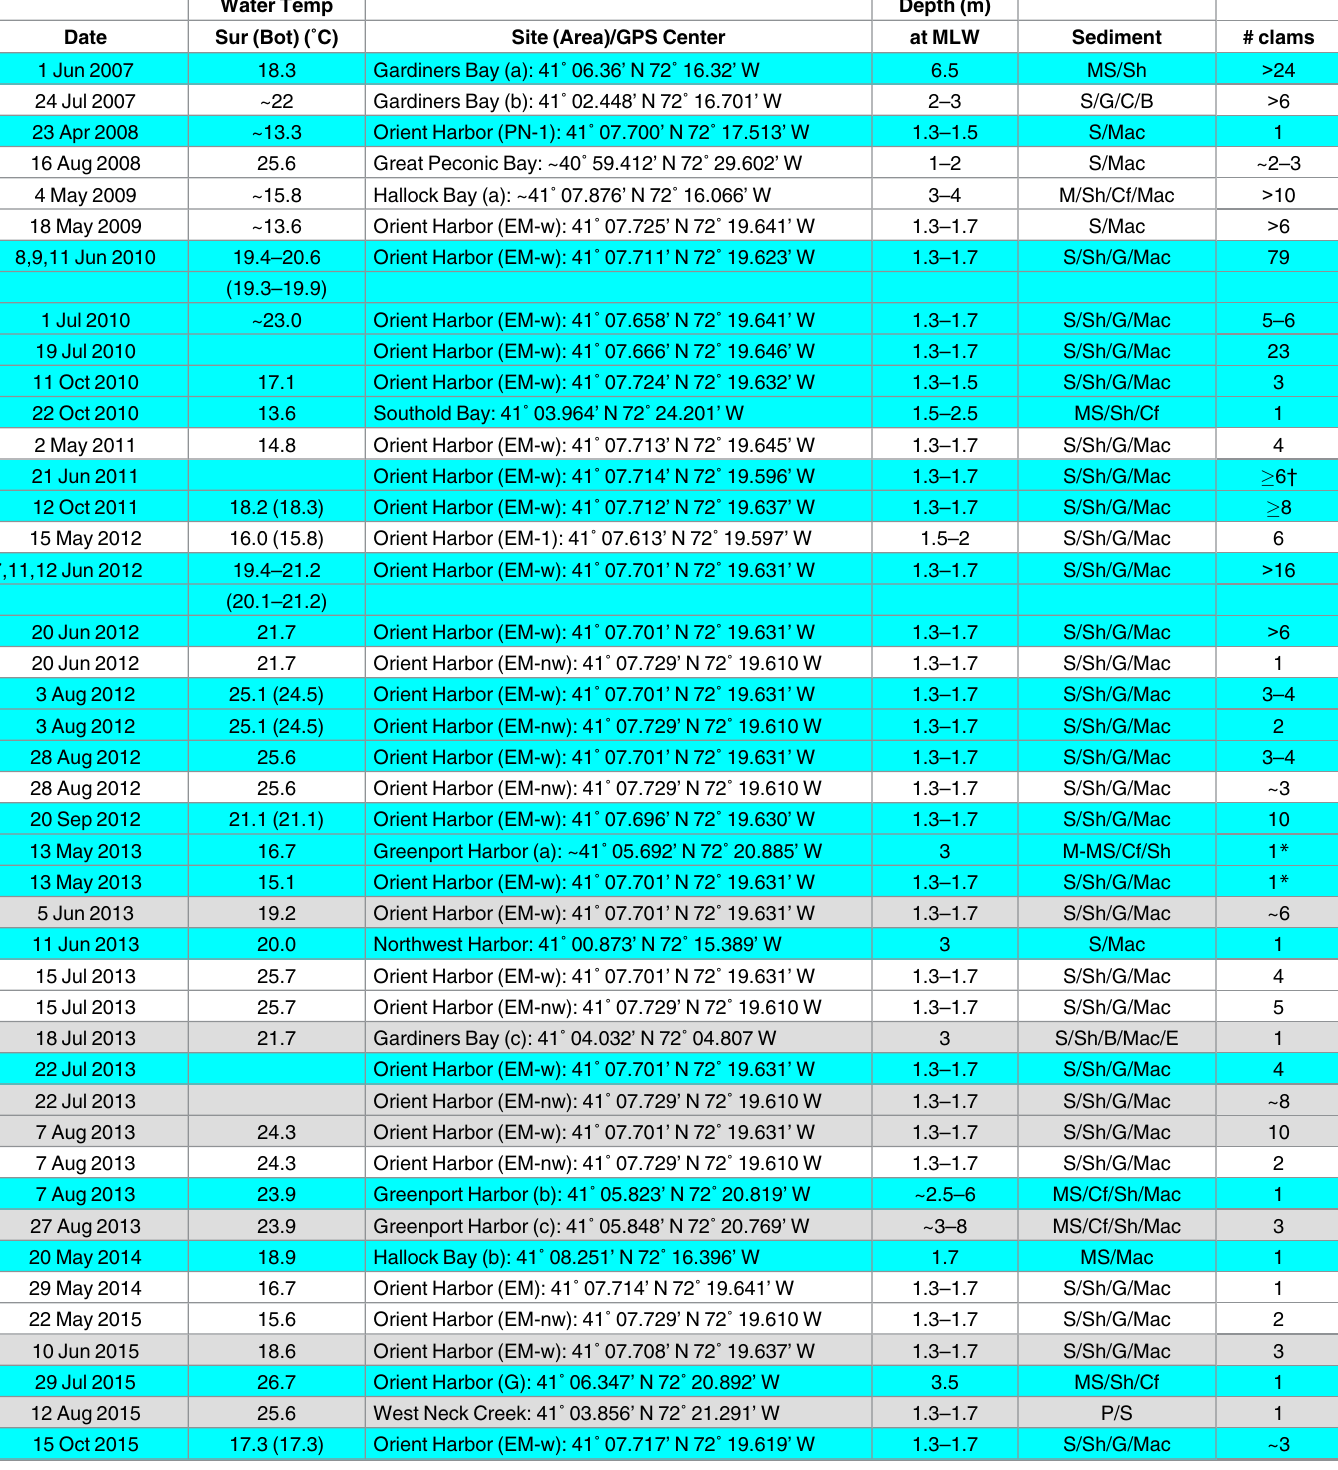
Table 1. Opportunistic observations of actively walking and non-walking epibenthic hard clams, Mercenaria mercenaria ,made while diving in the Peconic Bays, New York, USA, June 2007 –June 2016. Water Temp Depth